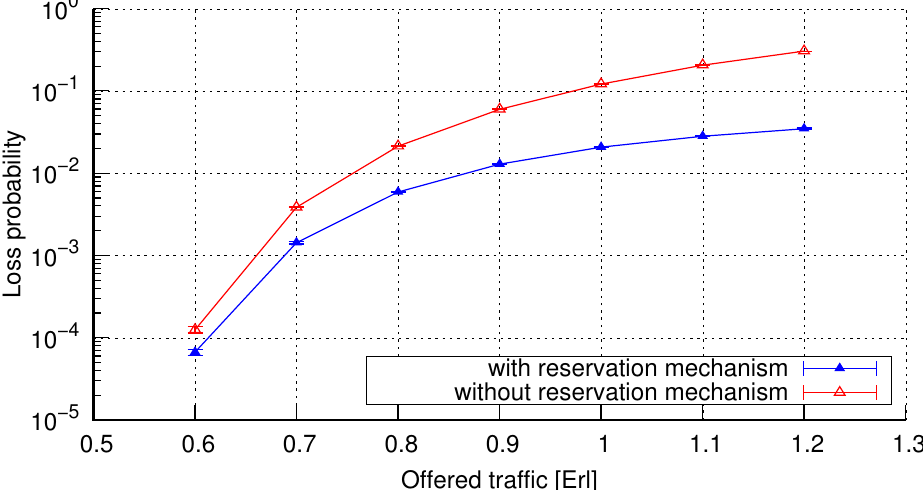
Figure 13. Loss probability for calls of class 3 (privileged class) in System 2.